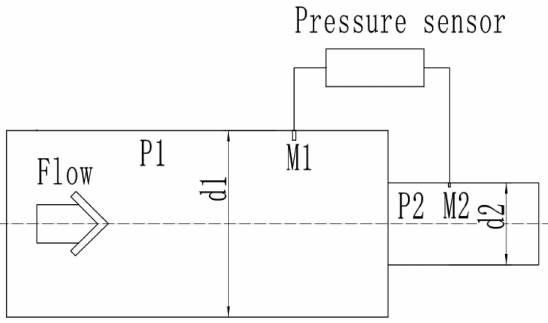
Figure 2. Scheme diagram of differential pressure